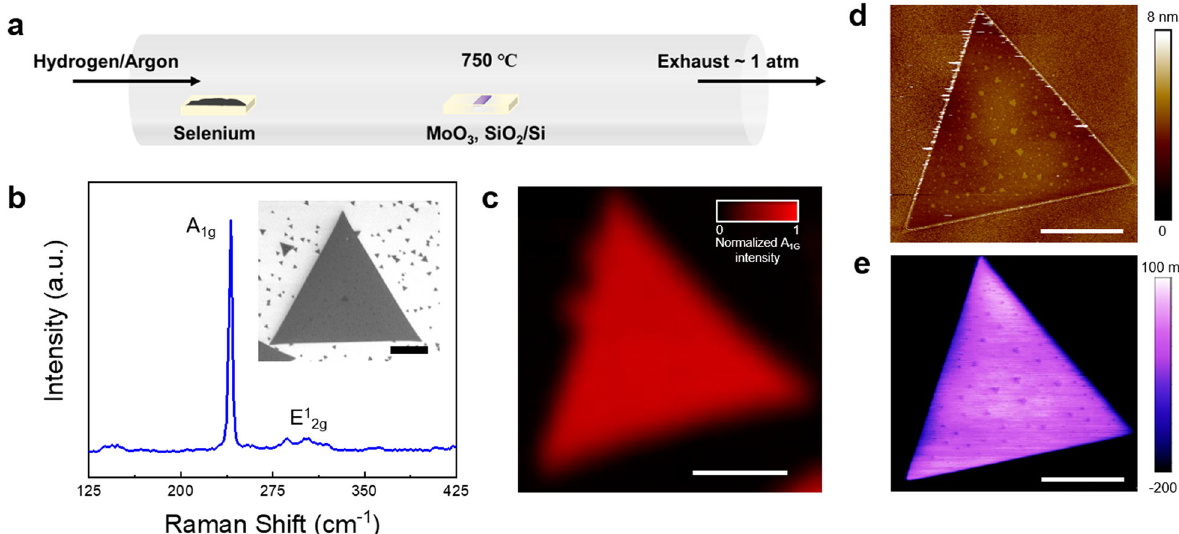
Fig. 1 Synthesis and initial characterization of monolayer MoSe 2 . a Schematic of powder vaporization synthesis process, b Raman and SEM image of monolayer MoSe 2 fl ake with inset image scale bar equal to 10 µm, c far- fi eld Raman map of A 1G peak intensity with scale bar indicative of 5 µm, d topography and e KPFM potential map with scale bars equivalent to 10